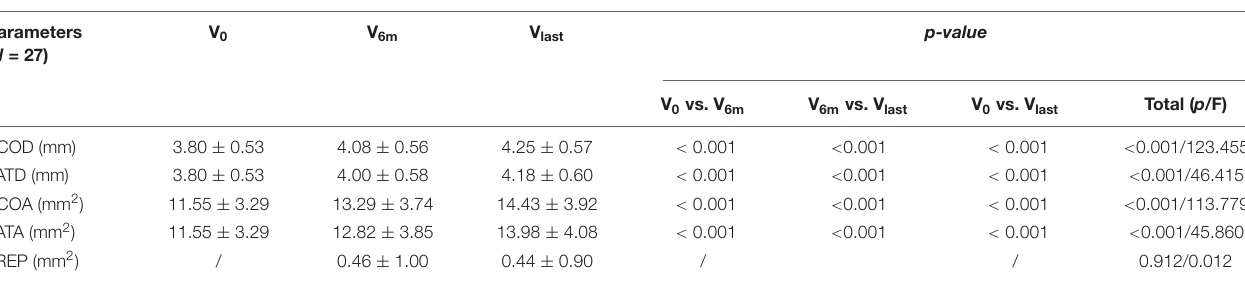
TABLE 1 | Posterior capsular opening/visual axis transparent areas and diameters after